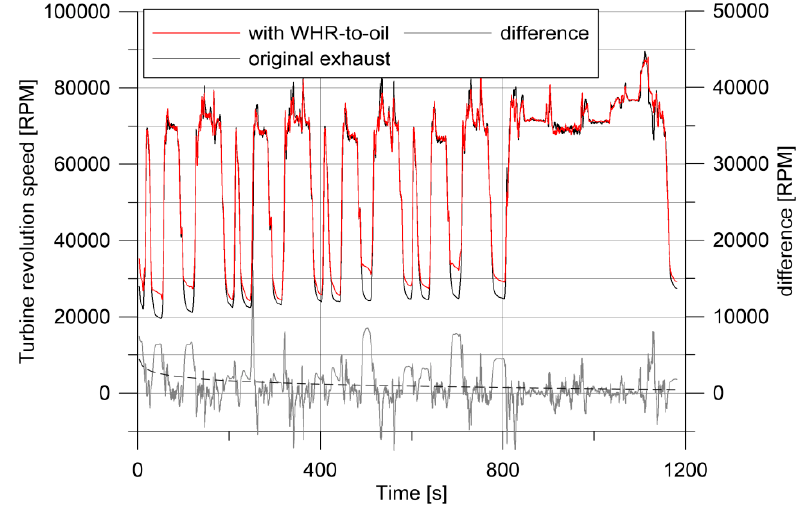
Figure 18. Turbocharger speed in the two test cases performed.